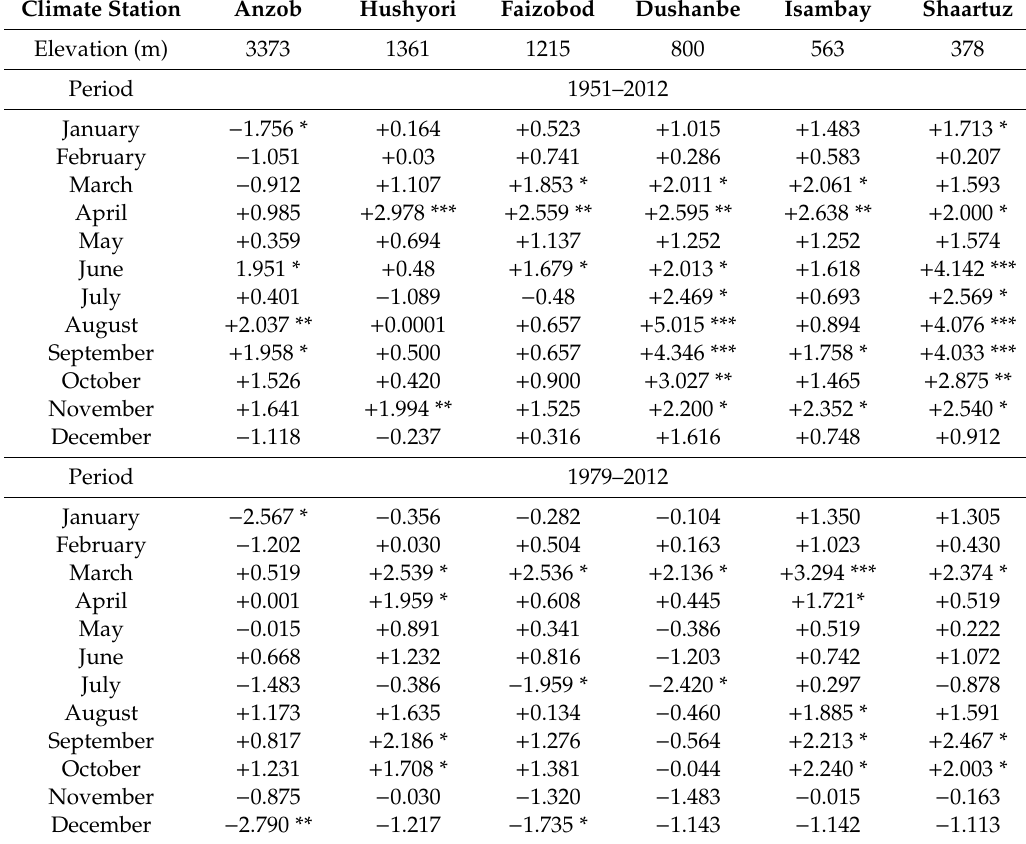
Figure 4. The mean annual precipitation anomalies over land areas for the globe and one latitudinal band from the five global precipitation datasets CRU, GHCN, GPCC, Smith et al. and GPCP compared to the period of 1981–2000 (Source: IPCC report, 2013 [60]).